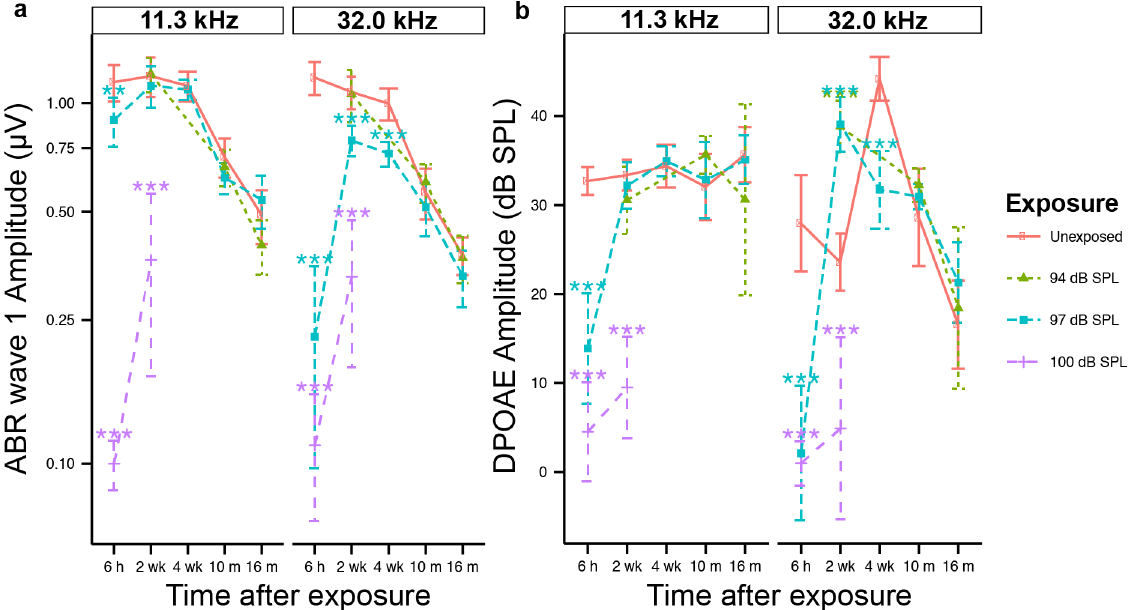
Fig 2. Neural response is reduced following neuropathic noise. ABR wave I peak-to-peak amplitudes ( a ) and DPOAE amplitudes ( b ) in response to 11.3 kHz tones (left column) and 32.0 kHz tones (right column) recorded from 6 hours to 16 months post exposure to noise causing PTS (100 dB SPL, purple), neuropathic noise causing TTS (97 dB SPL, blue), non-neuropathic noise causing TTS (94 dB SPL, green), and unexposed animals (red). ABR amplitudes are in response to 80 dB SPL tones (the maximum level tested) and DPOAE amplitudes are in response to 80 dB SPL tones. Noise parameters are as in Fig 1. Statistical significance of the group differences is indicated by asterisks: * : p < 0 . 05 , ** : p < 0 . 01 , *** : p < 0 . 001 . Data are group means ± SD. N = 5 – 9 mice per time point for noise-exposed and control groups.